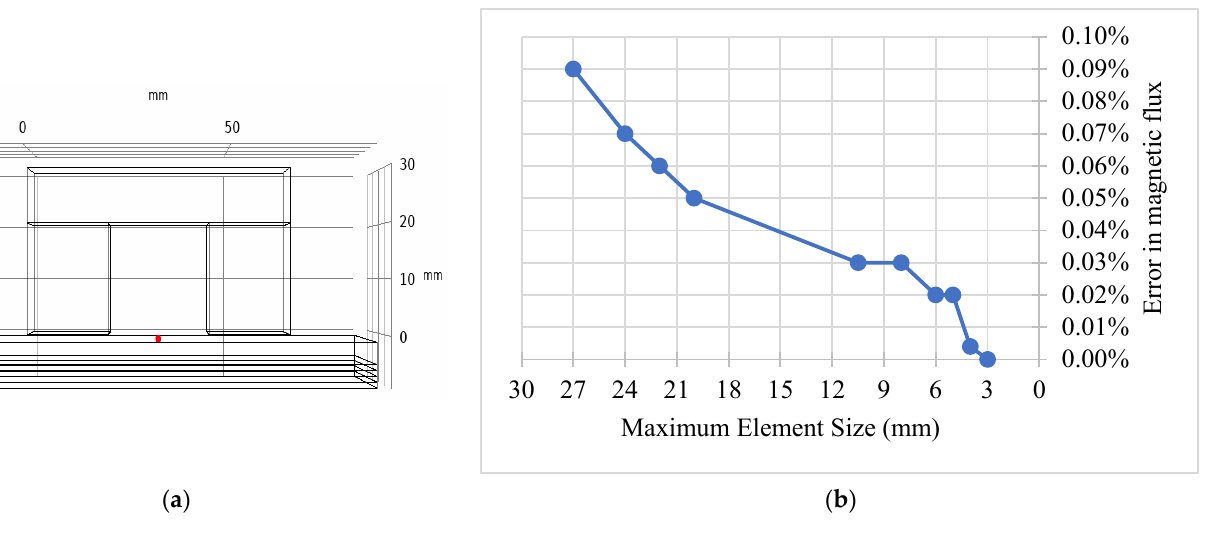
Figure 3. ( a )The location of the point at which the magnetic flux was computed for mesh convergence study, and ( b ) the graph showing the decrease in the error between the flux values with mesh refinement. Table 2. The mesh parameters obtained from mesh convergence study.